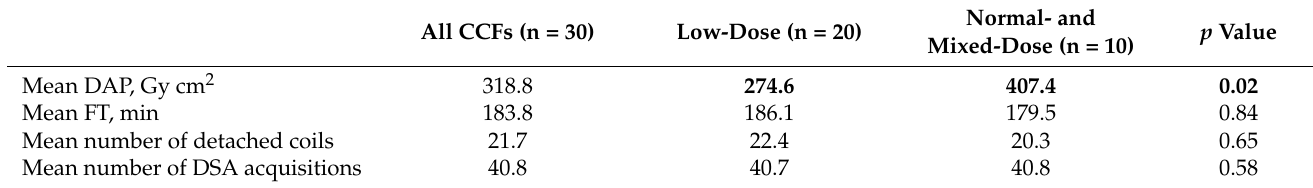
Table 4. Comparison of dosimetric data and number of implanted coils between treatment groups with different DSA protocols.